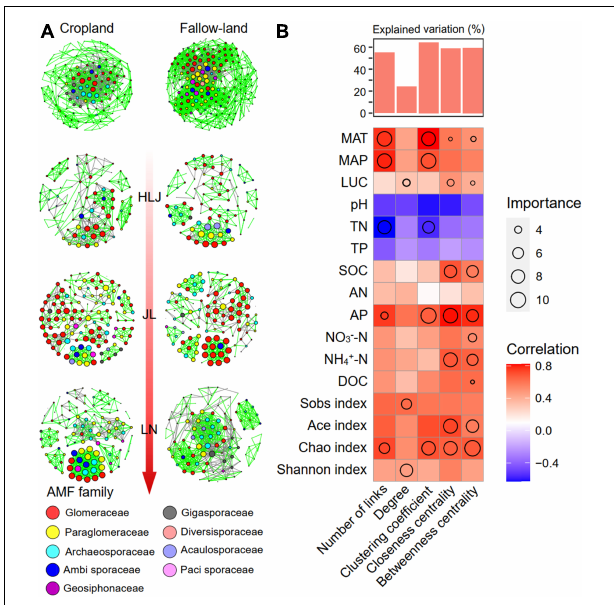
FIGURE 3 | Topological features of co-occurrence network of the AMF community and their correlations with environmental variables. (A) Co-occurrence network analysis of the AMF community under different treatments. Each node represents an AMF OTU, and an edge represents a Spearman’s correlation with a correlation coefficient of > 0.8 or less than –0.8 that is statistically significant (FDR < 0.05); and (B) random forest regression estimating the effects of each environmental variable on network topological features. MAT, mean annual temperature; MAP, mean annual precipitation; DOC, dissolved organic carbon; SOC, soil organic carbon; AN, available nitrogen; AP, available phosphorus; TP, total phosphorus; TN, total nitrogen. NO 3 - -N, nitrate nitrogen; NH 4 + -N, ammonium